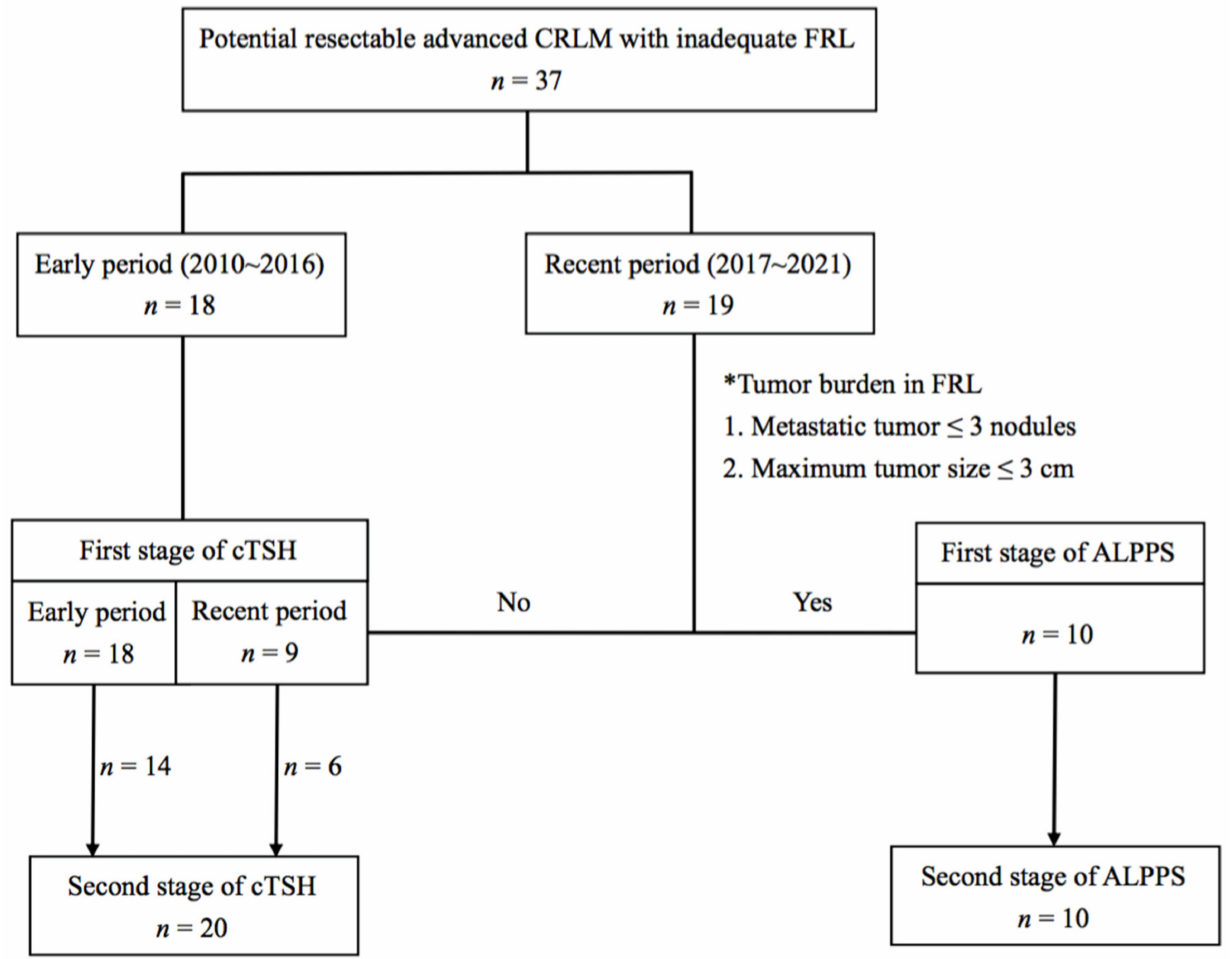
Figure 1. Flow diagram of patients who had undergone staged hepatectomy in this study. CRLM, colorectal liver metastasis; FRL, future remnant liver; cTSH, conventional two-stage hepatectomy; ALPPS, associating liver partition and portal vein ligation for staged